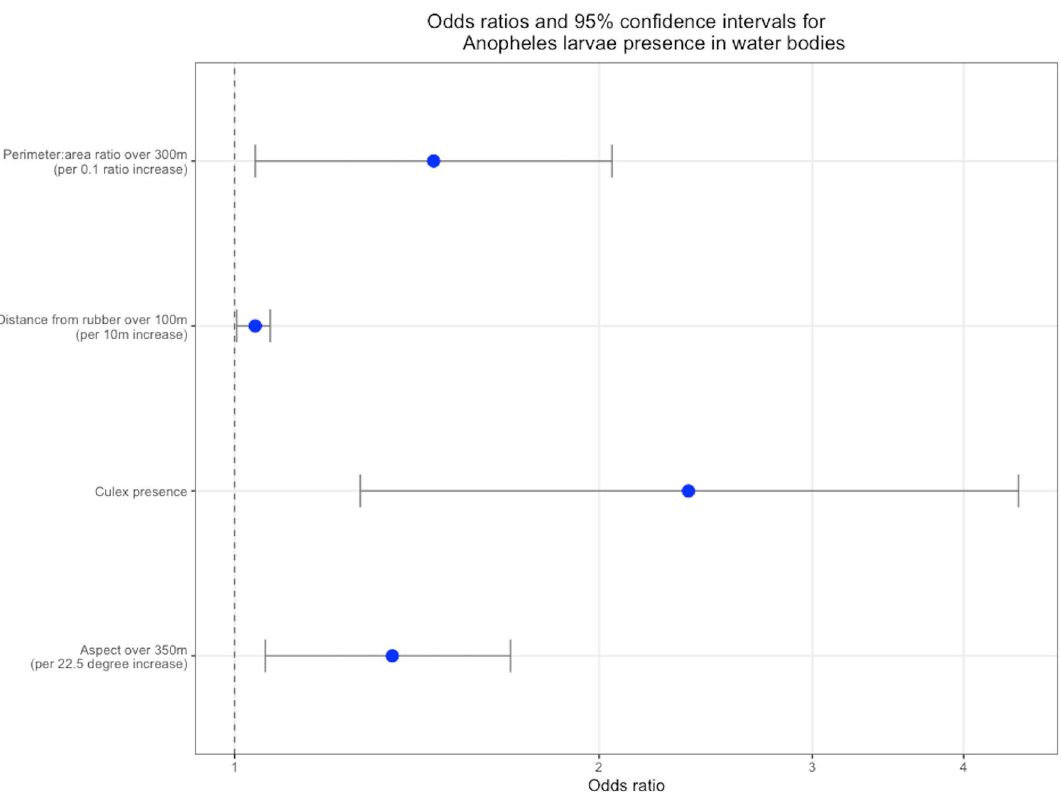
Figure 2. Odds ratios and 95% confidence intervals for risk factors for Anopheles larval habitats, at their most influential spatial